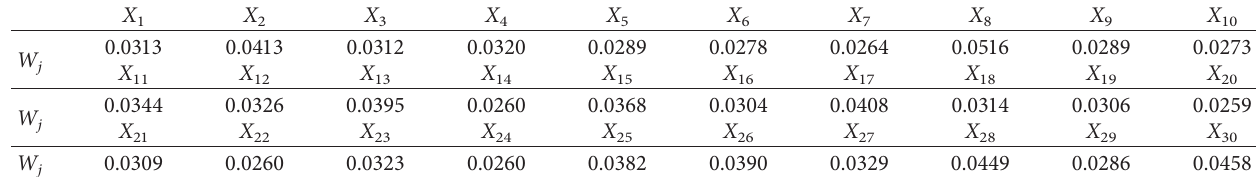
Table 2: Weights of indicators for the core competence of Chinese research